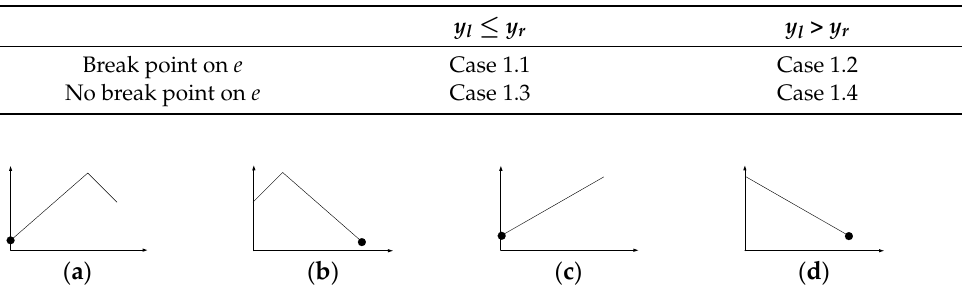
Figure A2. dist ( o , p ) × CI ( Q , p ) graphs for Case 1: ( a ) case 1.1, ( b ) case 1.2, ( c ) case 1.3, and ( d ) case 1.4.